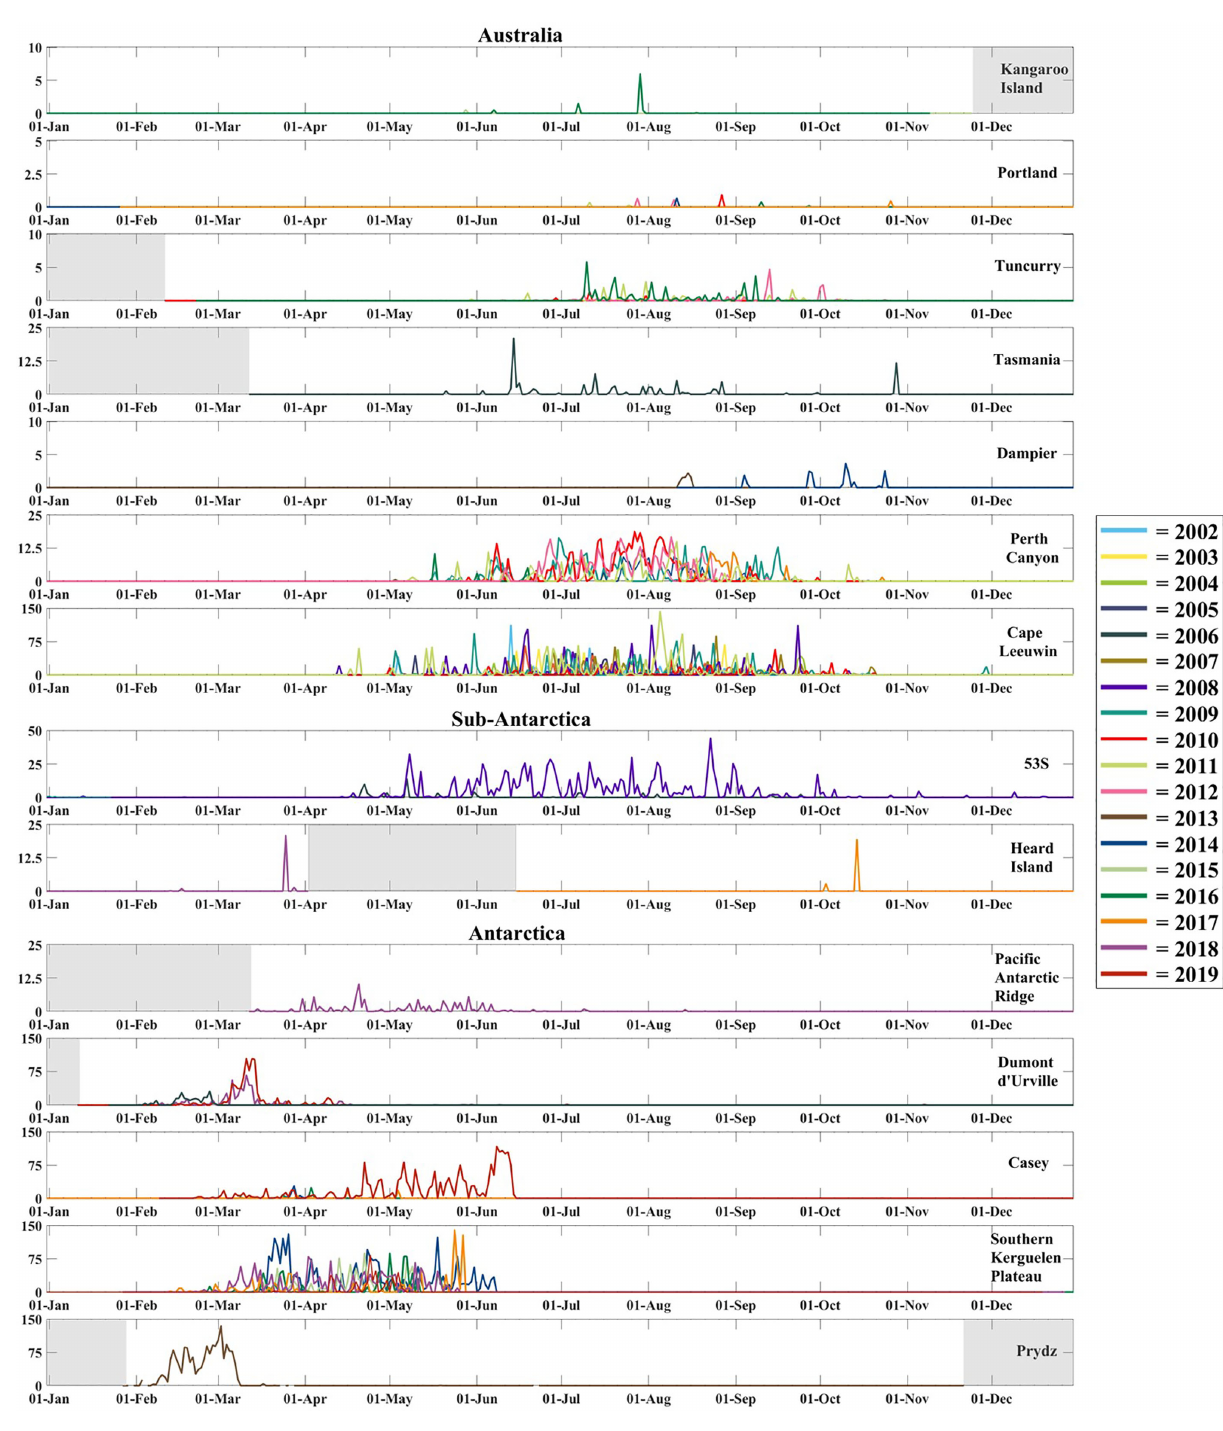
FIGURE 3 | Line-graphs of the fi n whale pulse rate [1/h] by day. I.e., number of pulses counted every 24 h, divided by the cumulative number of recording-seconds that day, × 3600 s/h) for all sites and years. Grey-shaded boxes indicate periods with no